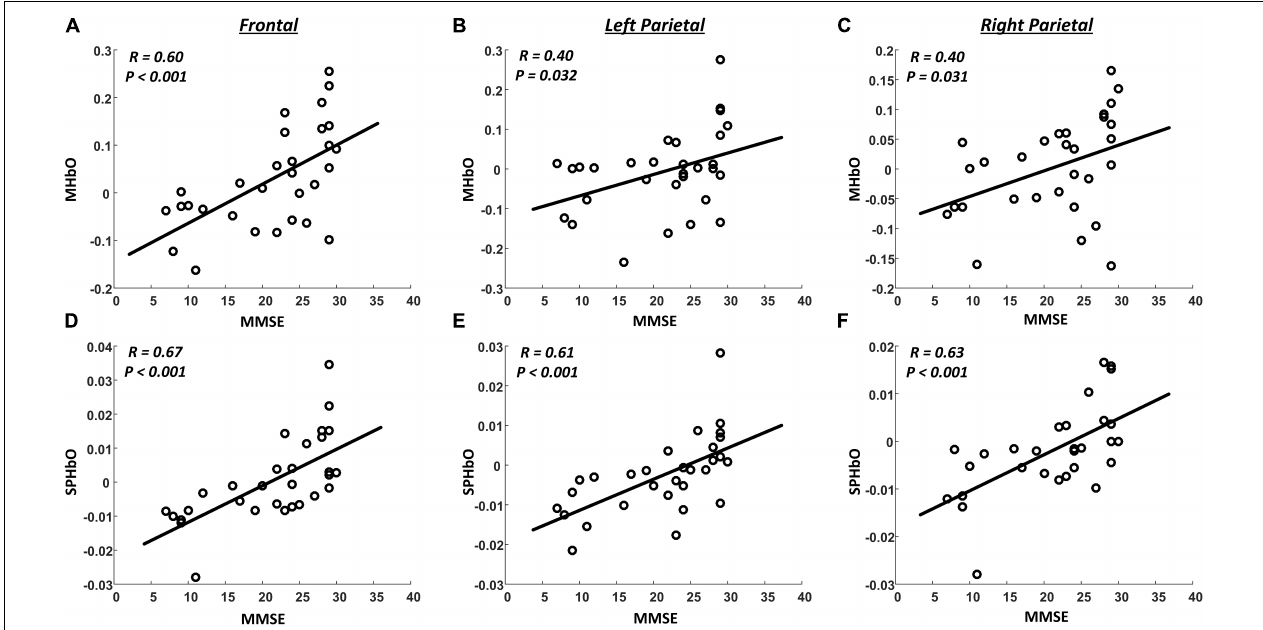
FIGURE 6 | Summary of correlation analysis results. The scatter plots (dots) denote the relationship between MMSE scores and fNIRS-derived indexes from all subjects ( A–C : MHbO; D–F : SPHbO). The lines are linear regression lines between MMSE scores and fNIRS-derived